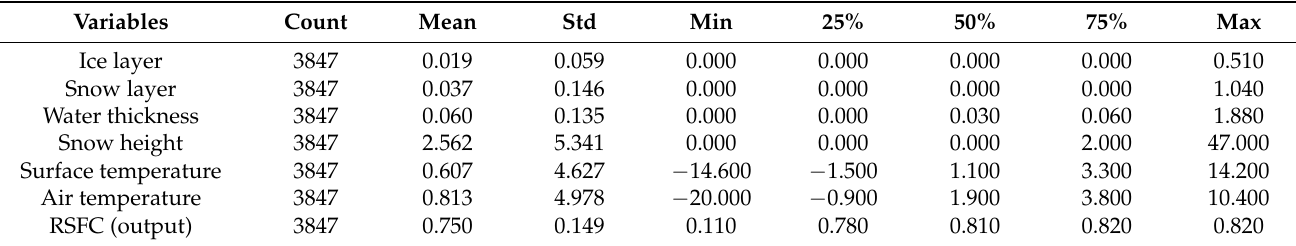
Figure 1. The framework used this study. Table 1. Statistical description of the dataset.